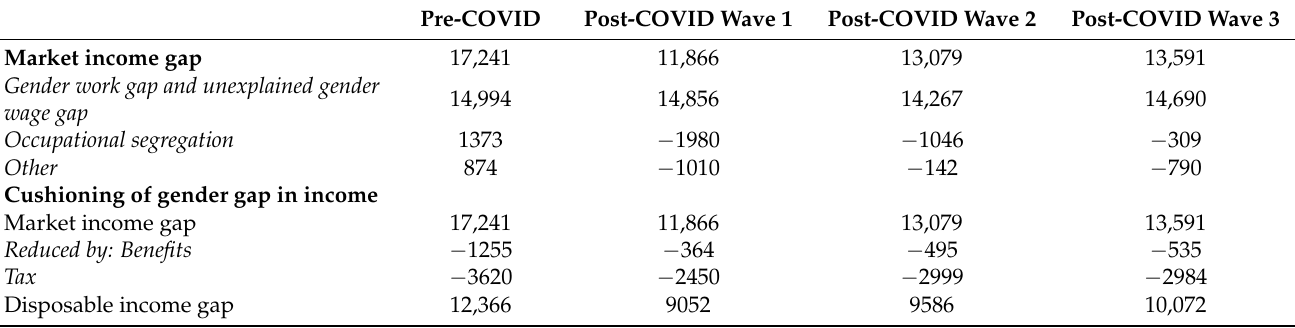
Table A3. The composition of market income (annual EUR) and the cushioning effect of the